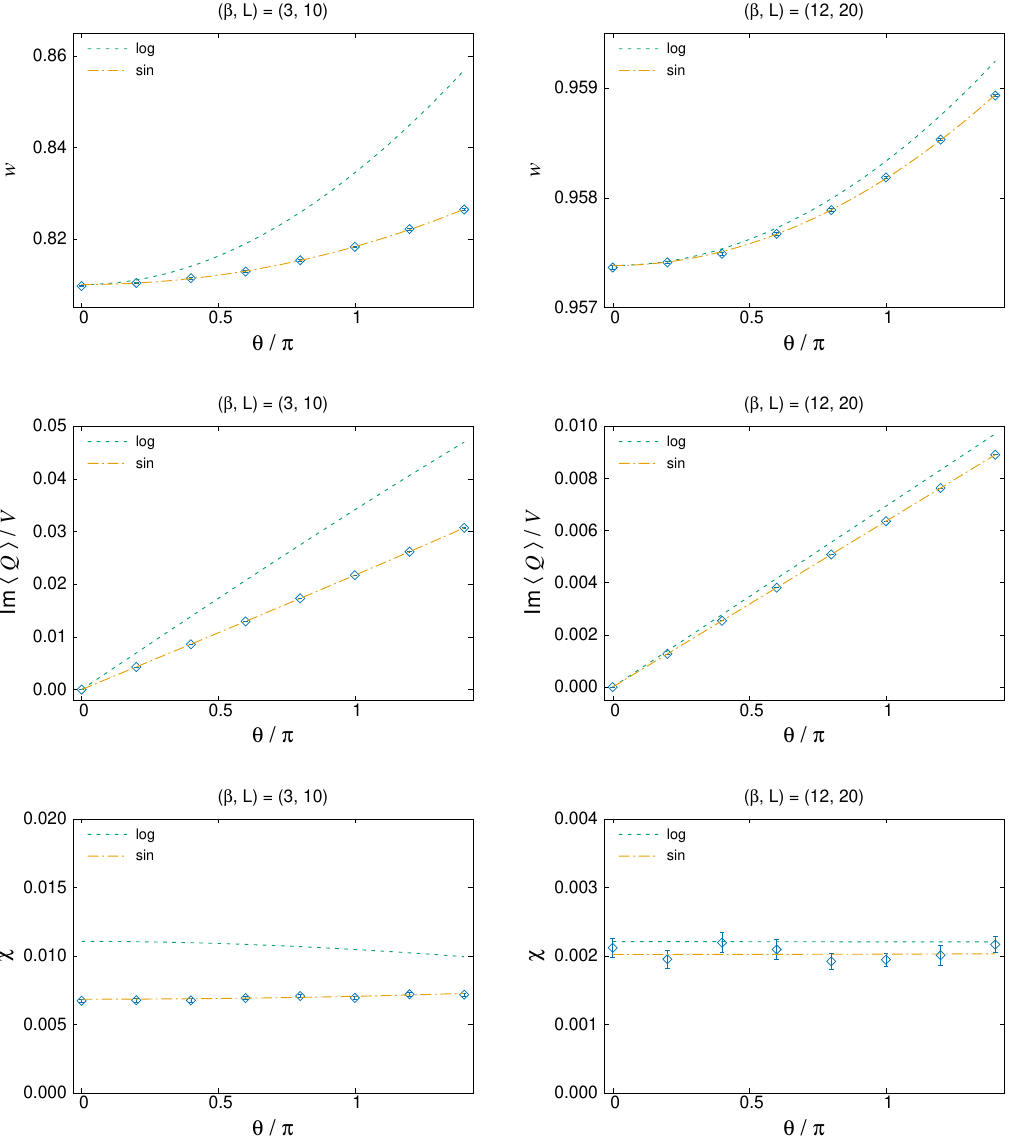
Figure 18 . The results for various observables obtained by the CLM for the punctured model with the sine de(cid:12)nition Q sin . The average plaquette (Top), the imaginary part of the topological charge density (Middle), the topological susceptibility (Bottom) are plotted against (cid:18) for ( (cid:12); L ) = (3 ; 10) (Left) and (12 ; 20) (Right). The exact results for the punctured model with the log and sine de(cid:12)nitions are shown for the same ( (cid:12); L ) by the dashed lines and the dash-dotted lines, respectively, for